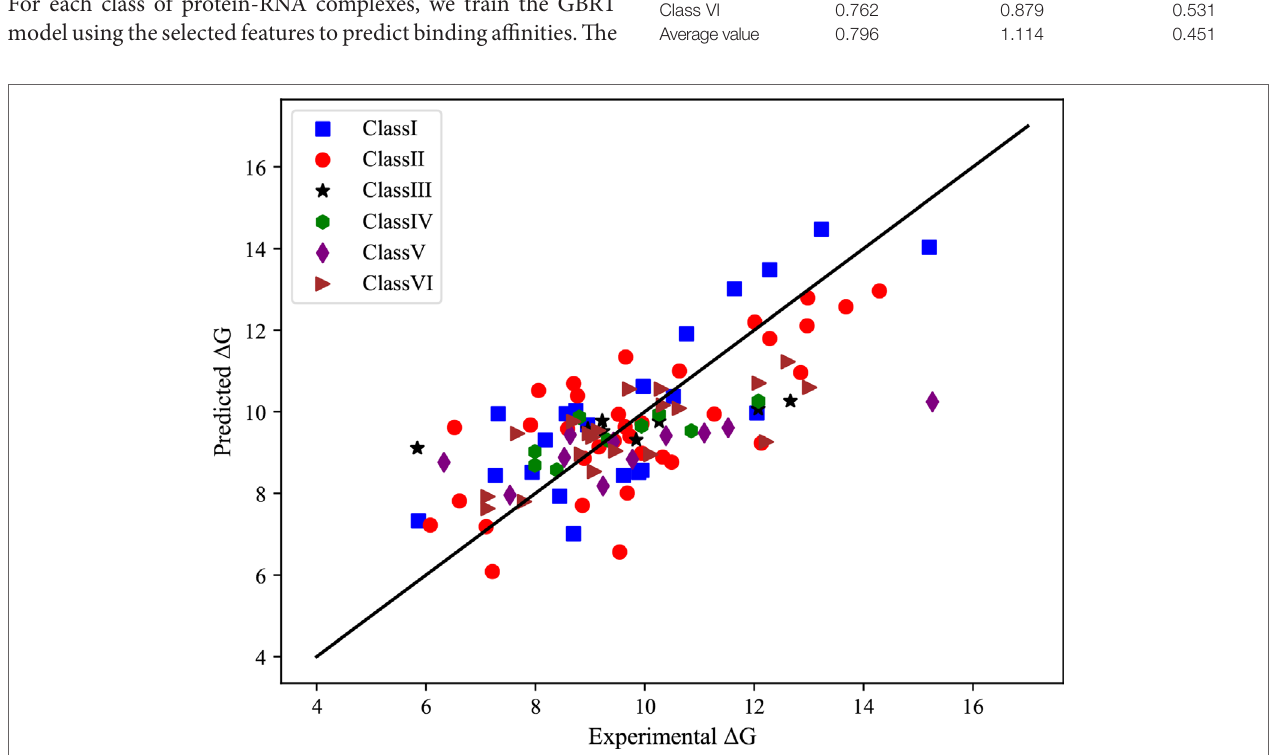
FIGURE 2 | Scatterplot in the coordinate of experimental vs predicted binding affinities of six classes of protein-RNA